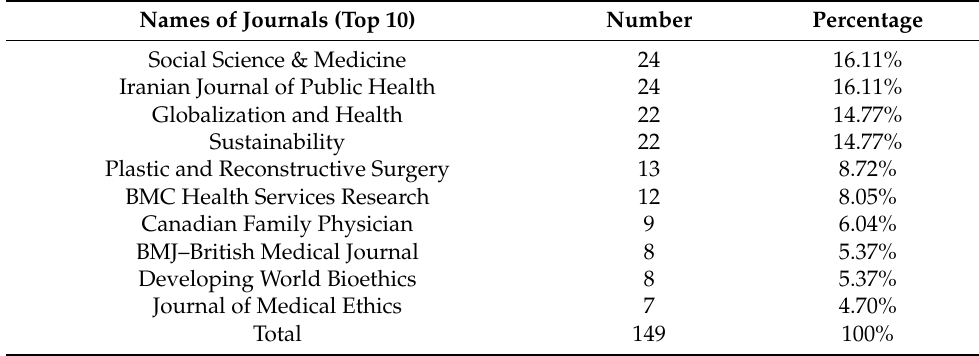
Table 2. Non-tourism journals publishing articles on medical-health-wellness tourism.